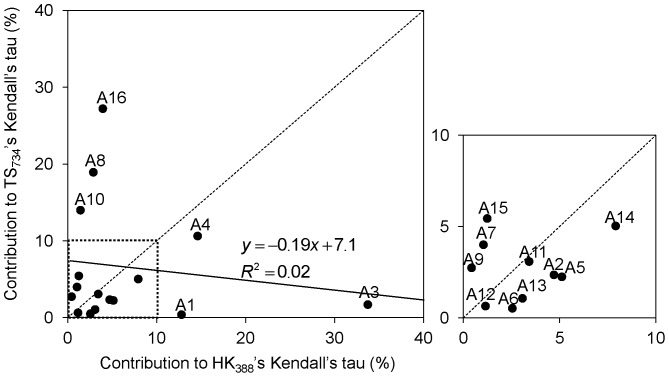
Contributions of the 16 tensor components to Kendall’s  (TS734 vs. HK388).The equations for computing the 16 tensor components have been reported previously [28].